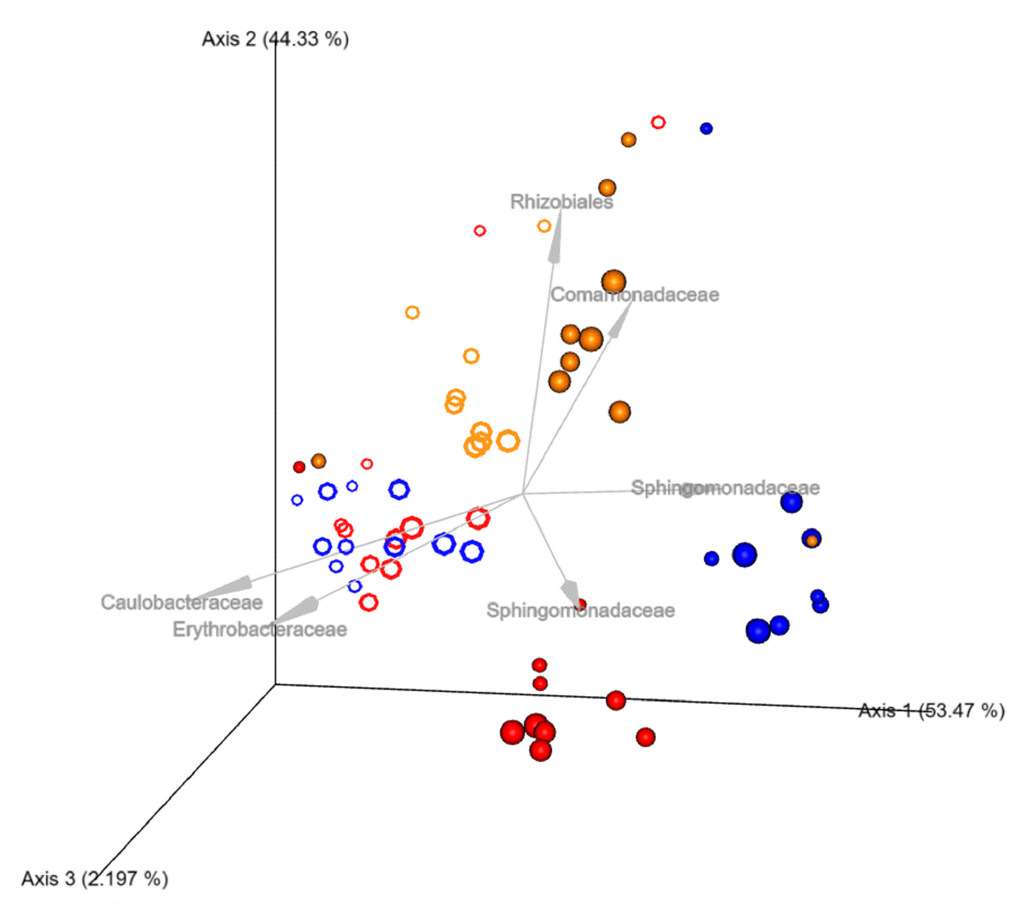
Figure 7. Robust Aitchison PCA generated from DEICODE showing taxa (arrows) correlated with the DWDSs scaled by week, from 1 to 6. NOTE: material code: red: copper, blue: PEX, orange: steel. Temperature code: ○ : 22 °C, ● :32 °C.